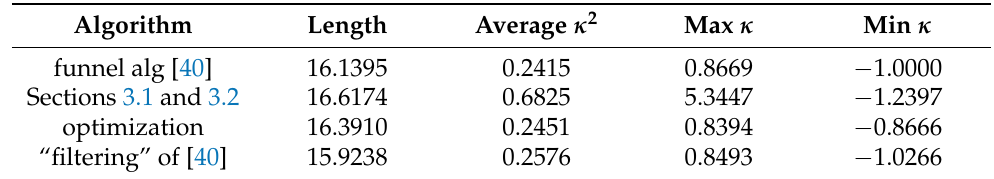
Table 1. Four properties of the paths obtained by four different path-construction methods in Example